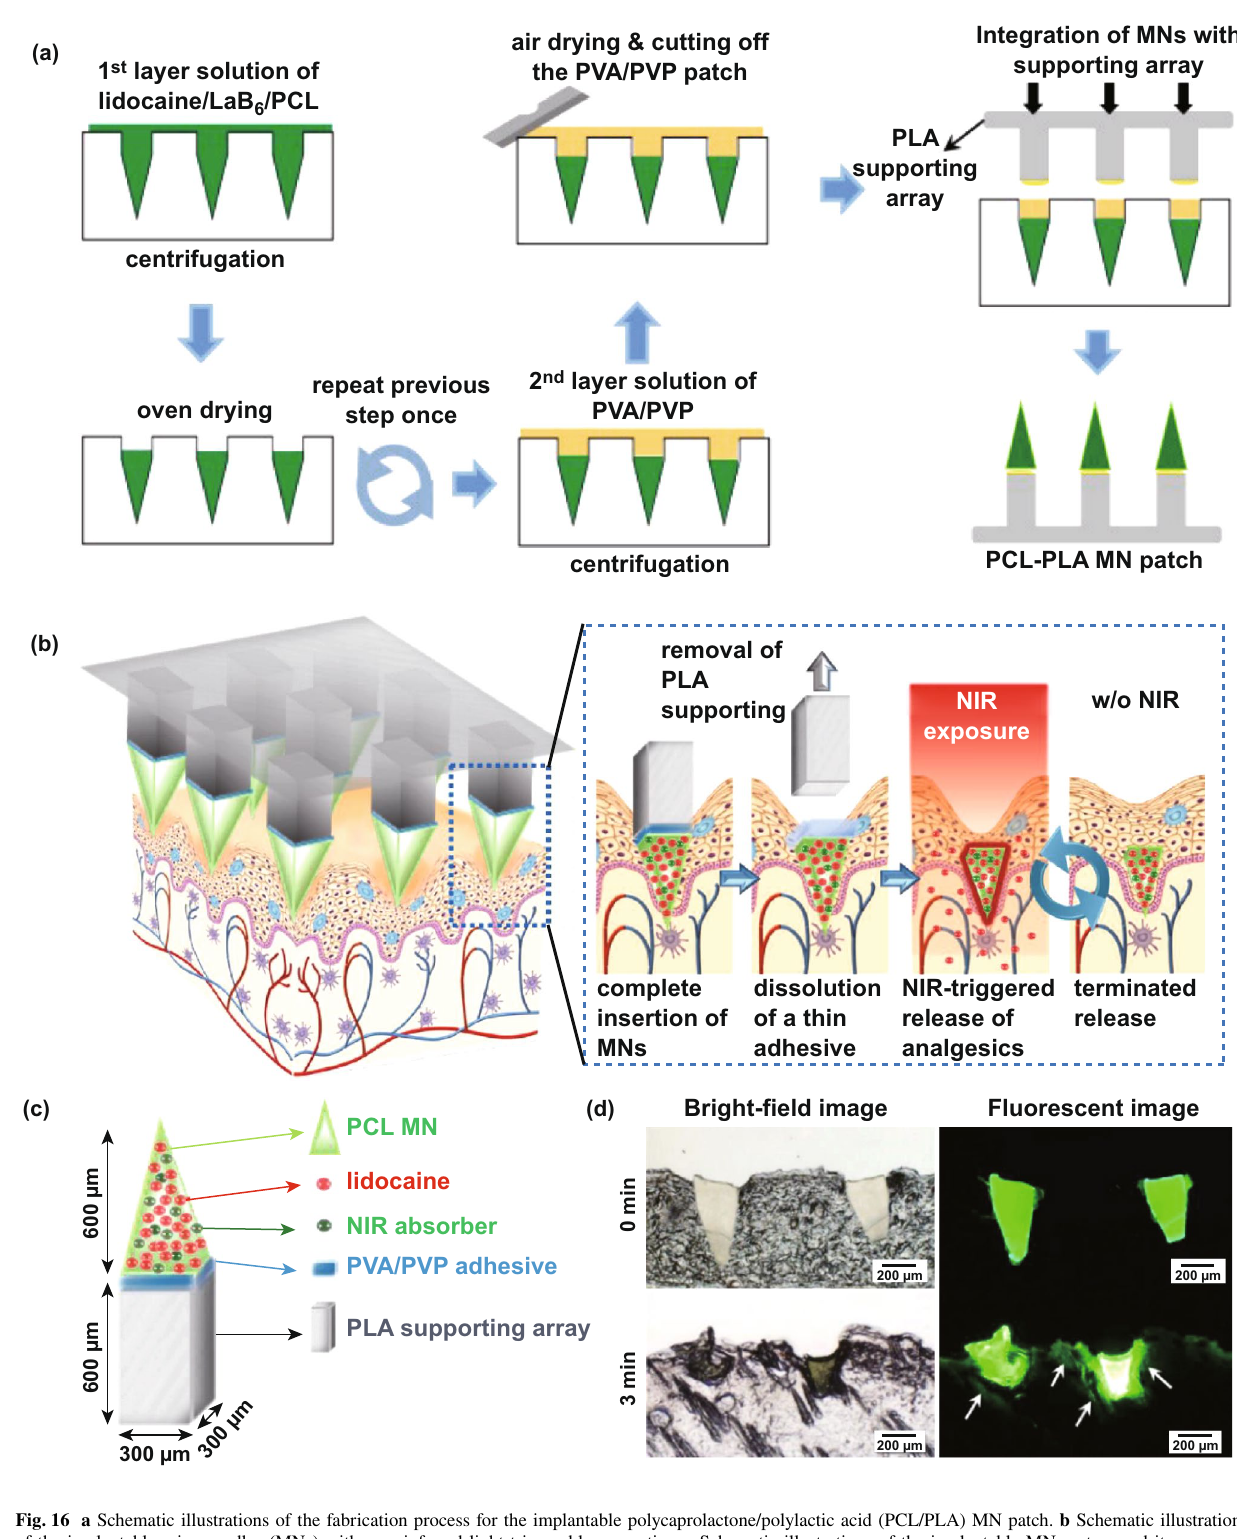
Fig. 16 a Schematic illustrations of the fabrication process for the implantable polycaprolactone/polylactic acid (PCL/PLA) MN patch. b Schematic illustrations of the implantable microneedles (MNs) with near-infrared light triggerable properties. c Schematic illustrations of the implantable MN system and its composi- tion, containing both the drug and near-infrared light absorber. d Histological sections of rat skin after insertion of coumarin 6-loaded MNs and then exposure to a near-infrared laser for 0 and 3 min. The arrows show the diffusion of the released coumarin 6 into the skin. PVP: polyvinylpyrrolidone; PVA: polyvinyl alcohol. Reprinted from Ref. [193] with permission from Royal Society of